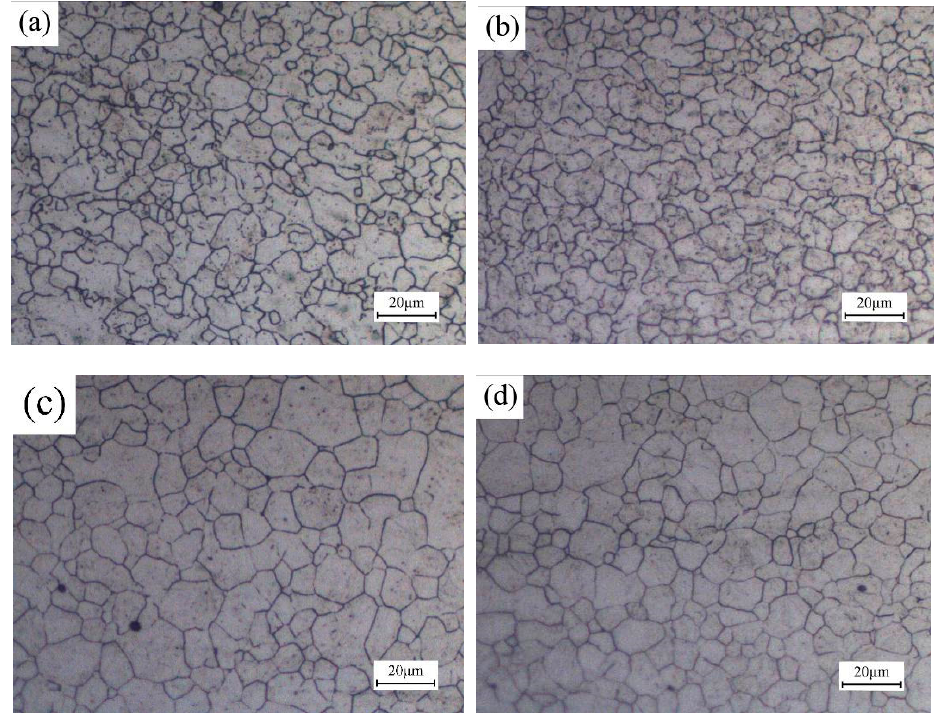
Figure 9. Grain morphology of FZ ( a ) welding speed 22 mm / s; ( b ) welding speed 40 mm / s, and grain morphology of CGZ ( c ) welding speed 22 mm / s; ( d ) welding speed 40 mm / s.